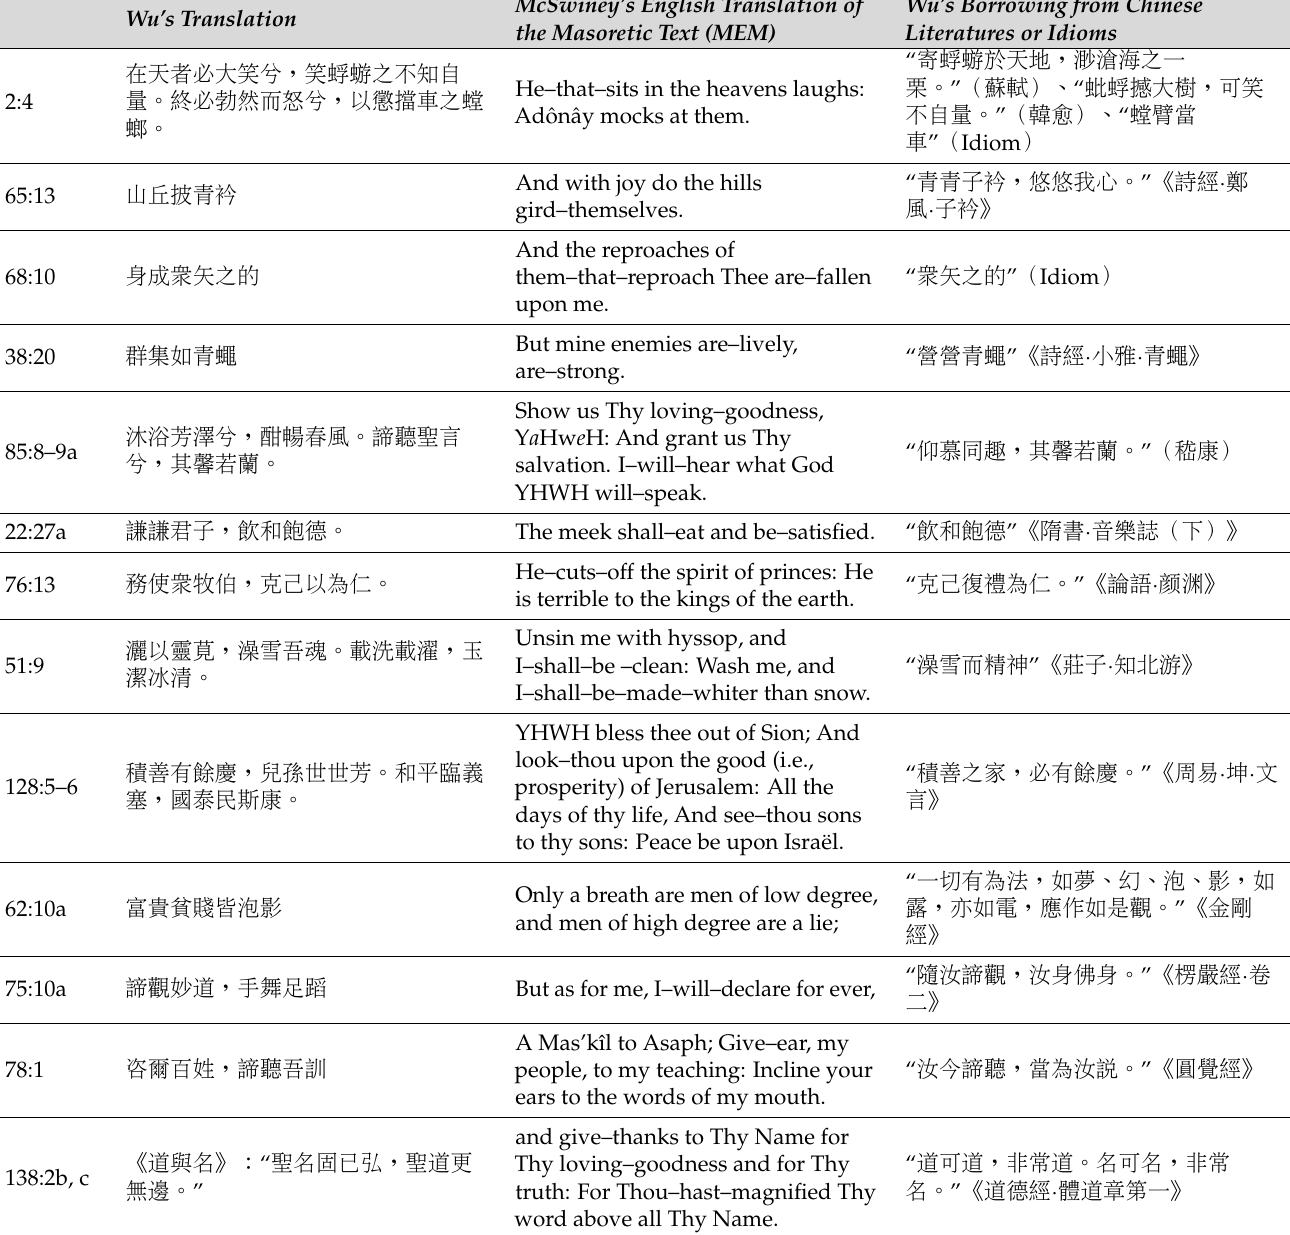
Table 1. Summing up Wu’s translation discussed in Section